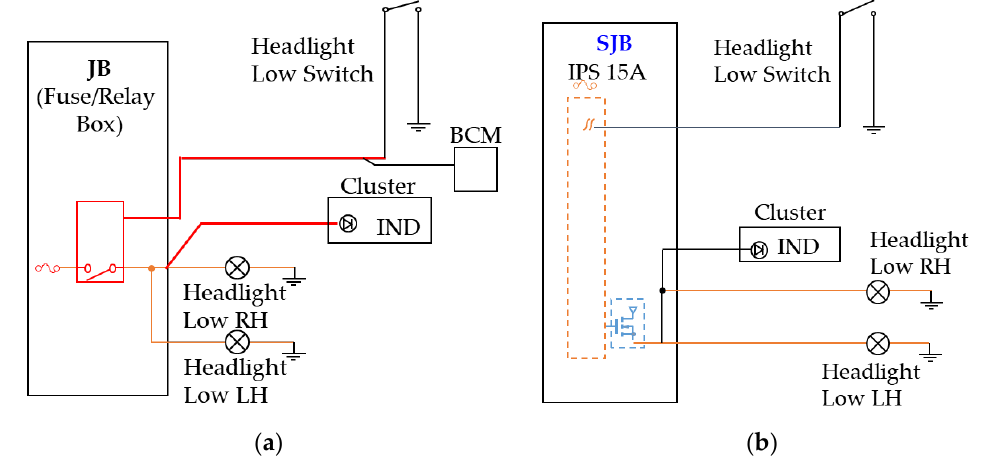
Figure 2. Schematics illustrating the differences between JBs and SJBs: ( a ) JBs and ( b ) SJBs.